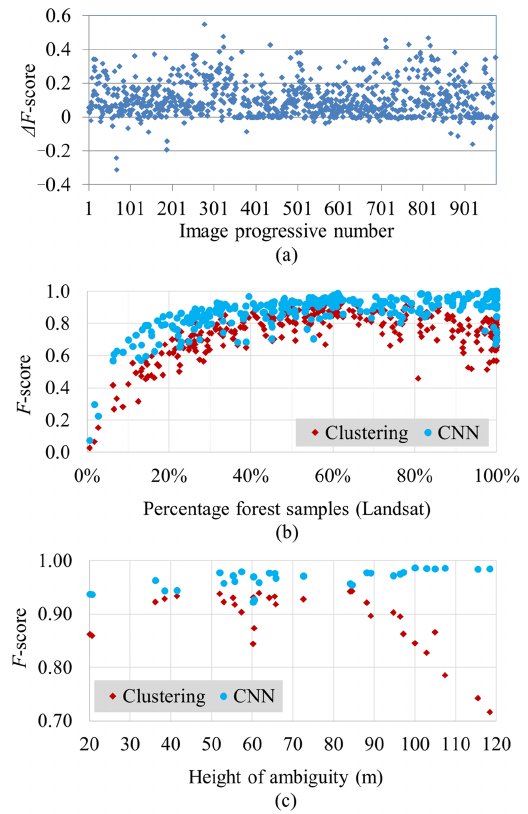
Figure 7. Performance comparison between forest classification maps obtained with the proposed deep learning approach (CNN) and with the baseline clustering approach used for the generation of the global TanDEM-X FNF map. ( a ) Difference in F -scores between the baseline clustering method and the proposed deep-learning-based approach. ( b ) F -scores for the two methods as functions of the forest density, estimated from Landsat reference data, and ( c ) F -scores for the two methods as functions of the h Amb